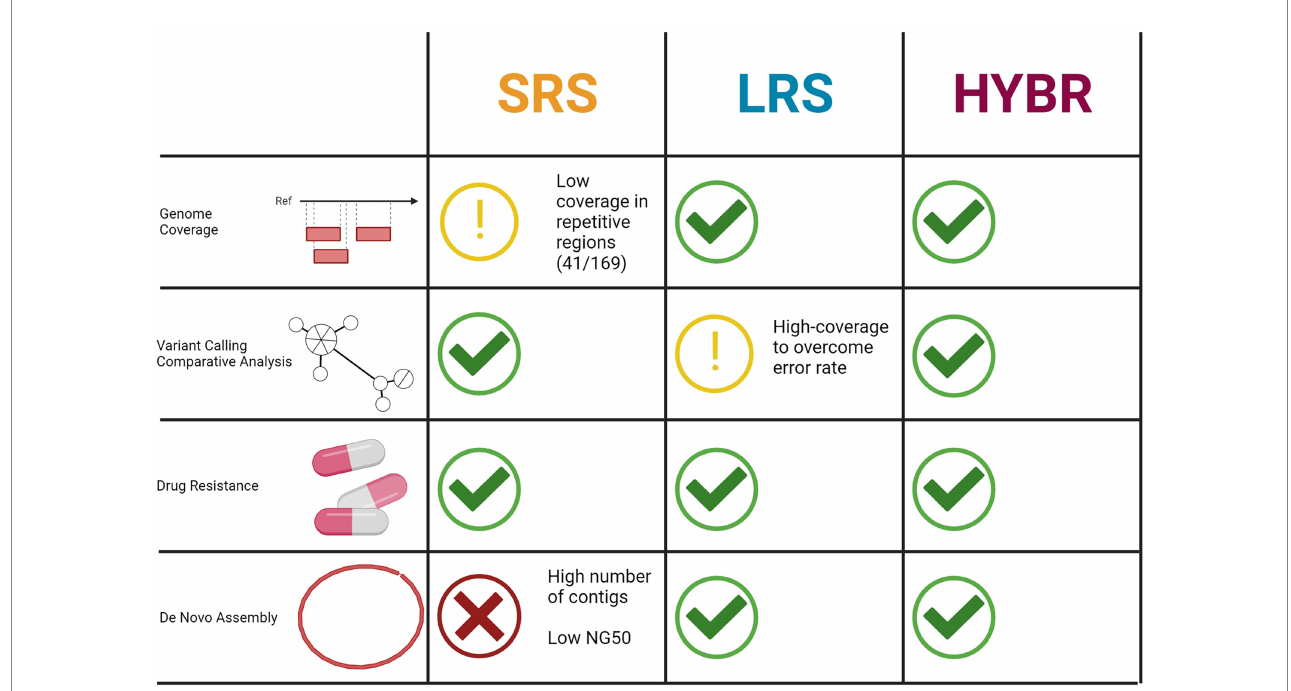
FIGURE 6 Tasks performance comparison between three approaches. Created with